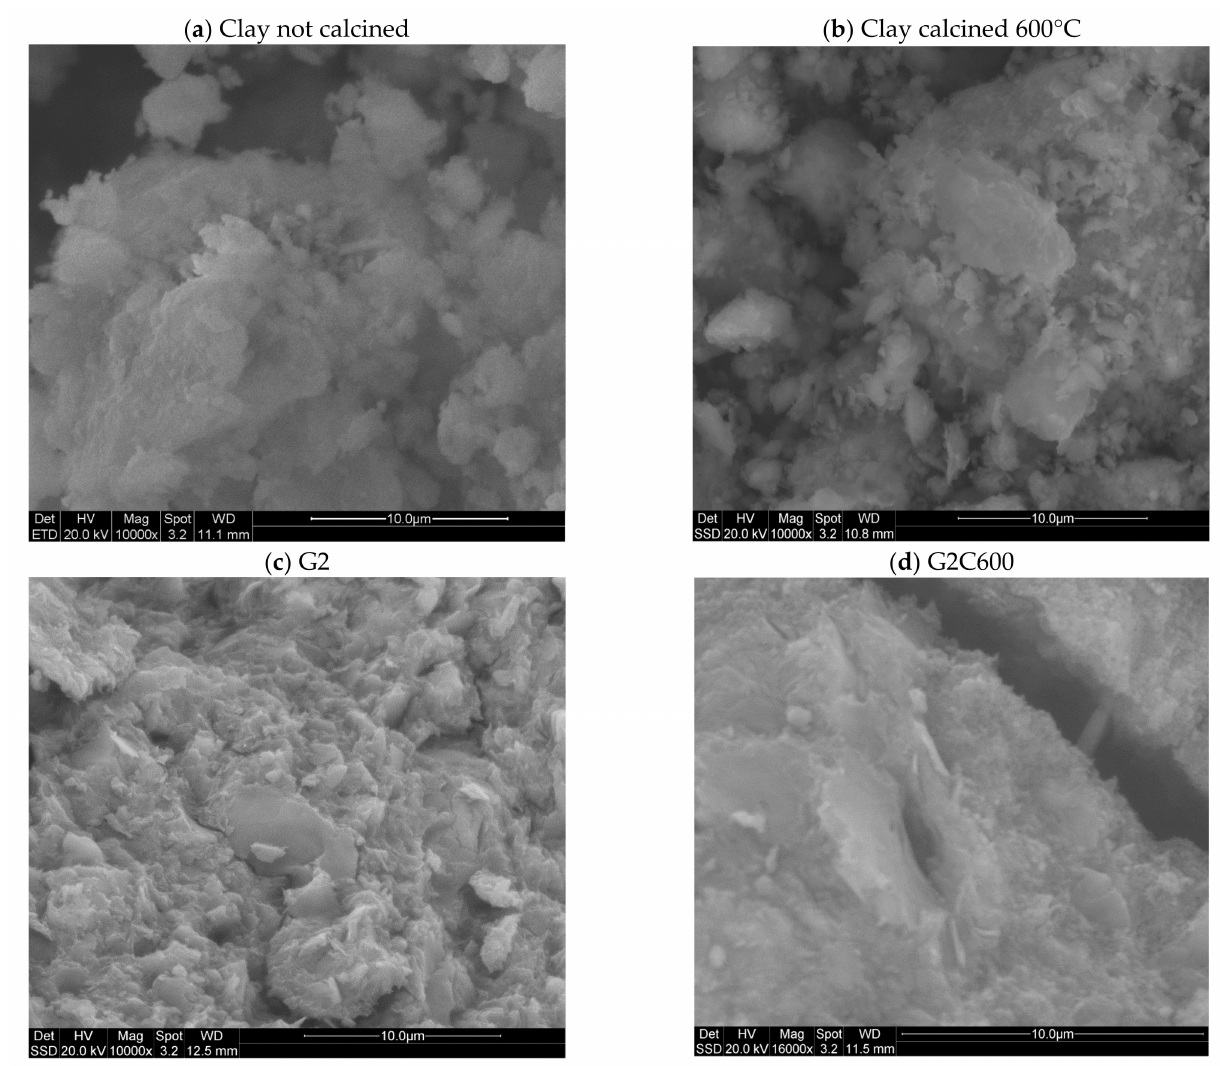
Figure 6. SEM images of the as-received clay by-product ( a ), calcined powder at 600 ◦ C ( b ), fractured surface of sample G2 ( c ), and G2C600 ( d